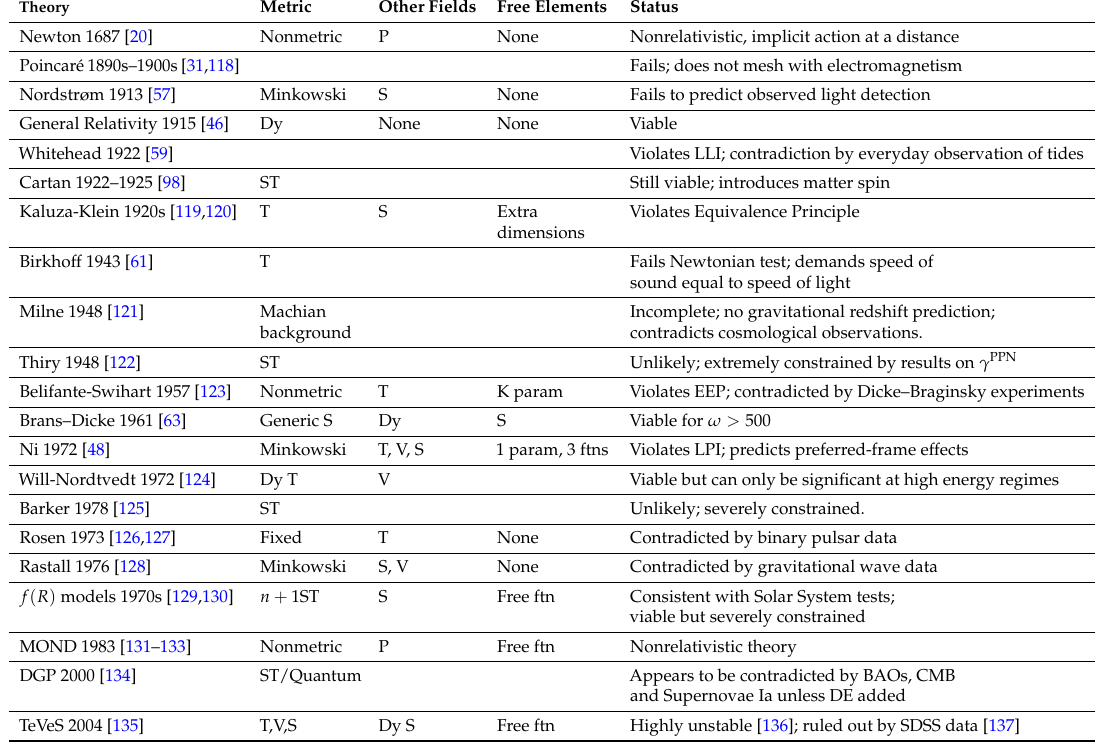
Table 1. A “comparative morphology” of some of the major alternatives to General Relativity, in approximate chronological order. We have only listed the theories of particular historical